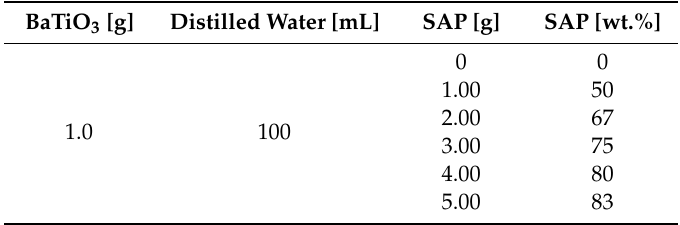
Table 1. Composition of the BaTiO 3 suspension stabilized by SAP.